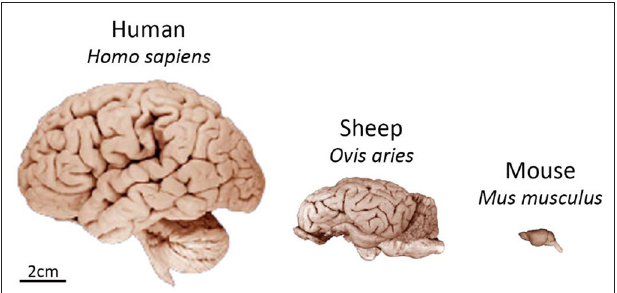
FIGURE 1 | Comparison of size and gross neuroanatomy of the sheep, human, and mouse brain. Images reproduced from the University of Wisconsin and Michigan State Comparative Mammalian Brain Collections and National Museum of Health and Medicine. Preparation of images and specimens funded by the National Science Foundation, as well as by the National Institutes of Health. University of Wisconsin and Michigan State Comparative Mammalian Brain Collections website http://neurosciencelibrary.org/index.